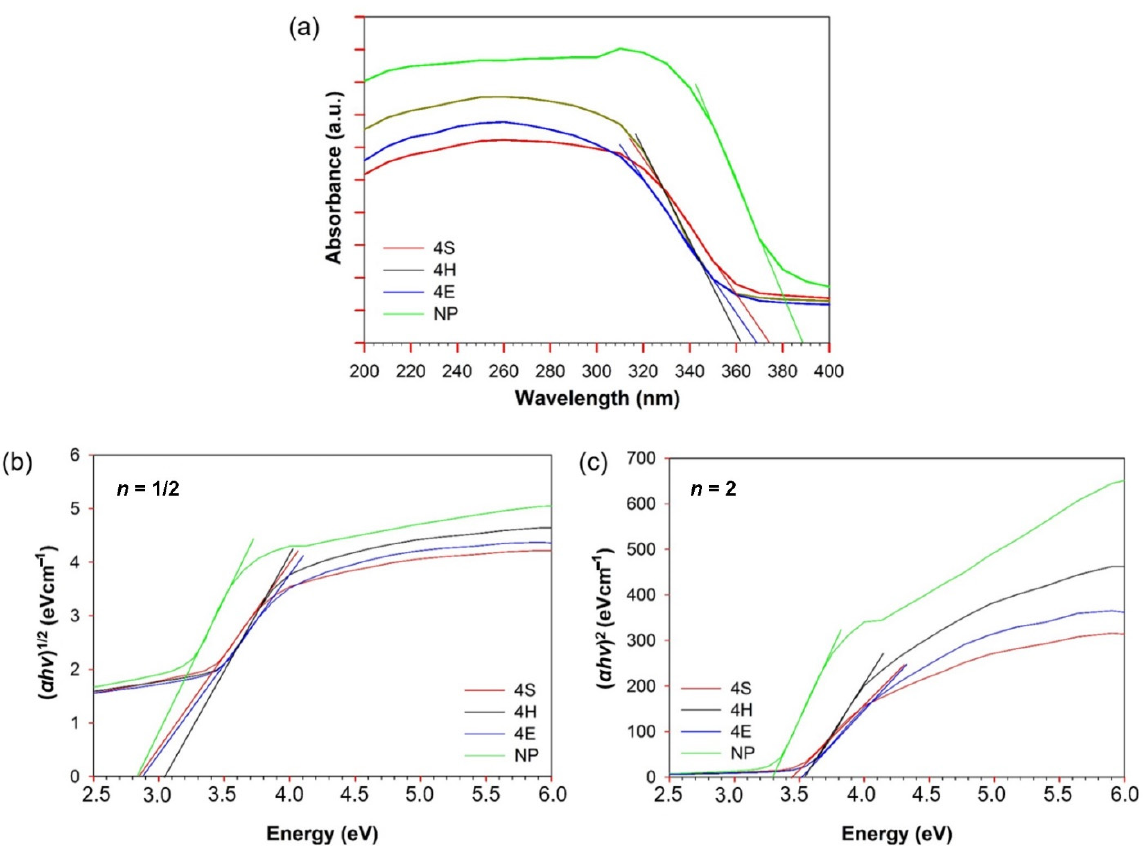
Figure 5. UV-vis absorbance spectra of the studied samples with the determination of Eg by the absorption edge method ( a ) and Tauc plotting ( α h ν ) n against photon energy ( h ν ) ( n = ½ ( b ) and n = 2 ( c )).